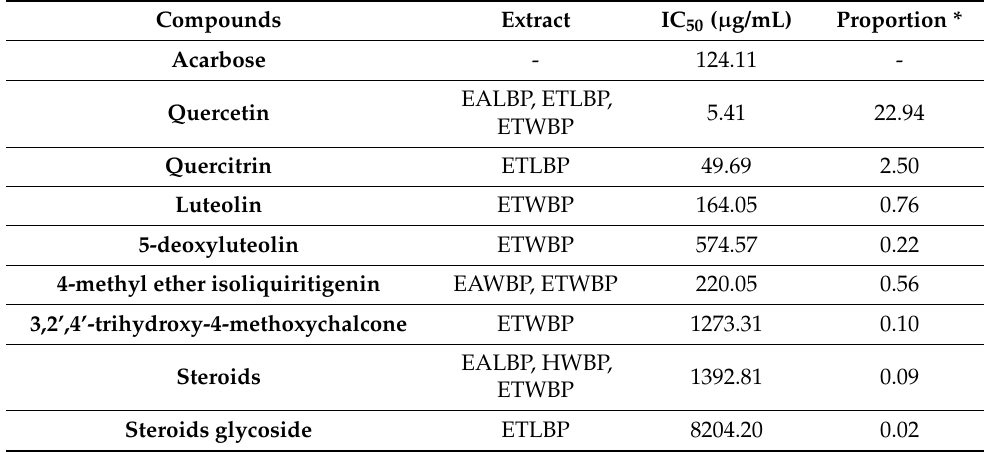
Table 2. Alpha-glucosidase inhibition of isolated compounds from Bauhinia pulla